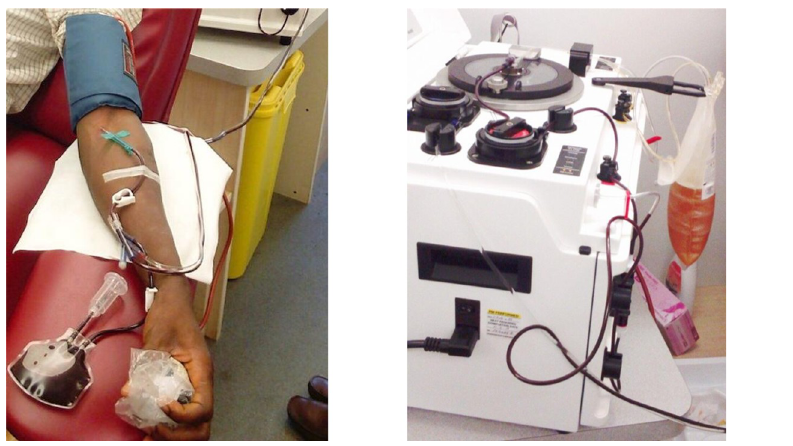
Fig 2. Plasmapheresis. Plasmapheresis during CP